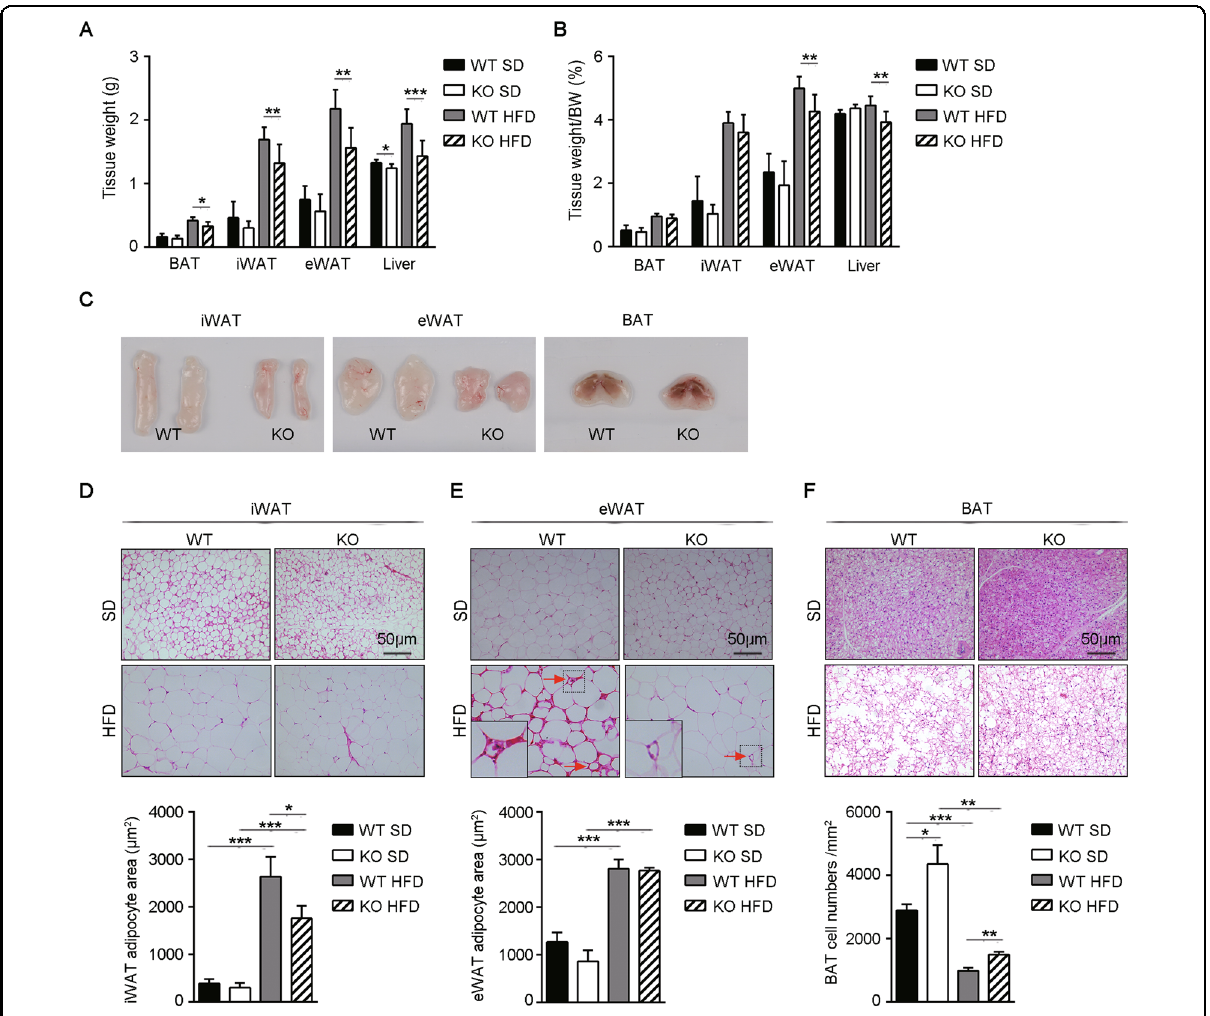
Fig. 2 Deletion of Gab2 reduces the adipose tissue weight in mice fed with HFD. A , B Tissue weight ( A ) and tissue weight ratio to bodyweight ( B ) of Gab2 KO and WT mice fed with SD and HFD diet for 12 weeks. C – F Representative image ( C ), hematoxylin and eosin (H&E) staining and adipocyte area of iWAT ( D ), eWAT ( E ) and BAT ( F ) from Gab2 KO and WT mice fed with SD and HFD diet for 12 weeks, scale bar is 50 μ m. The data are presented as mean ± SD from at least six mice in each group. Statistical difference is indicated: * P < 0.05; ** P < 0.01; *** P <